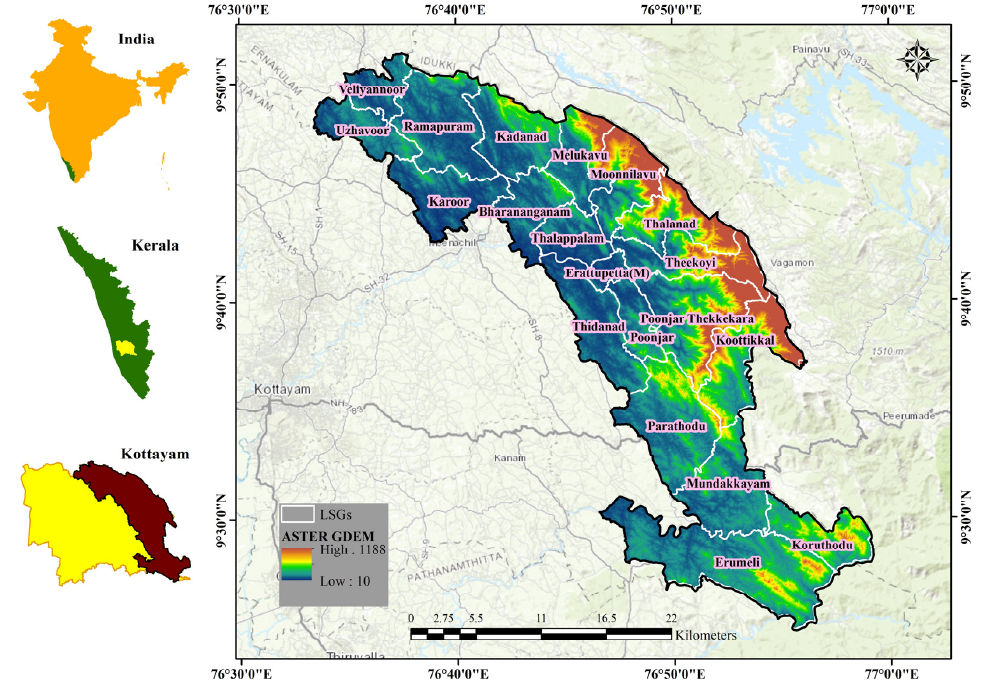
Figure 2. Location of the study